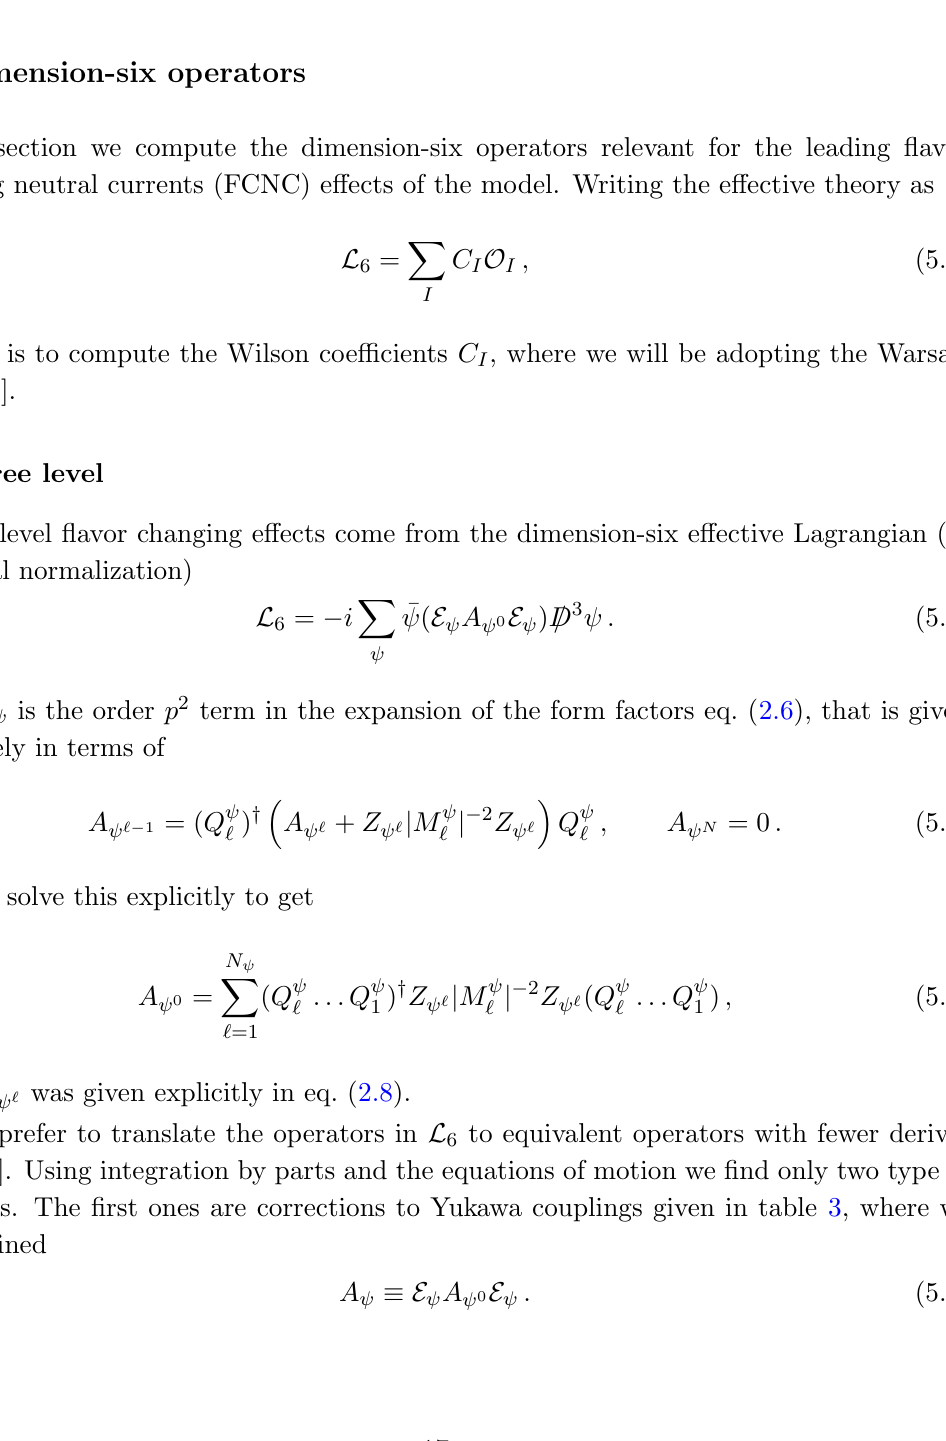
Table 3. Yukawa corrections and their Wilson